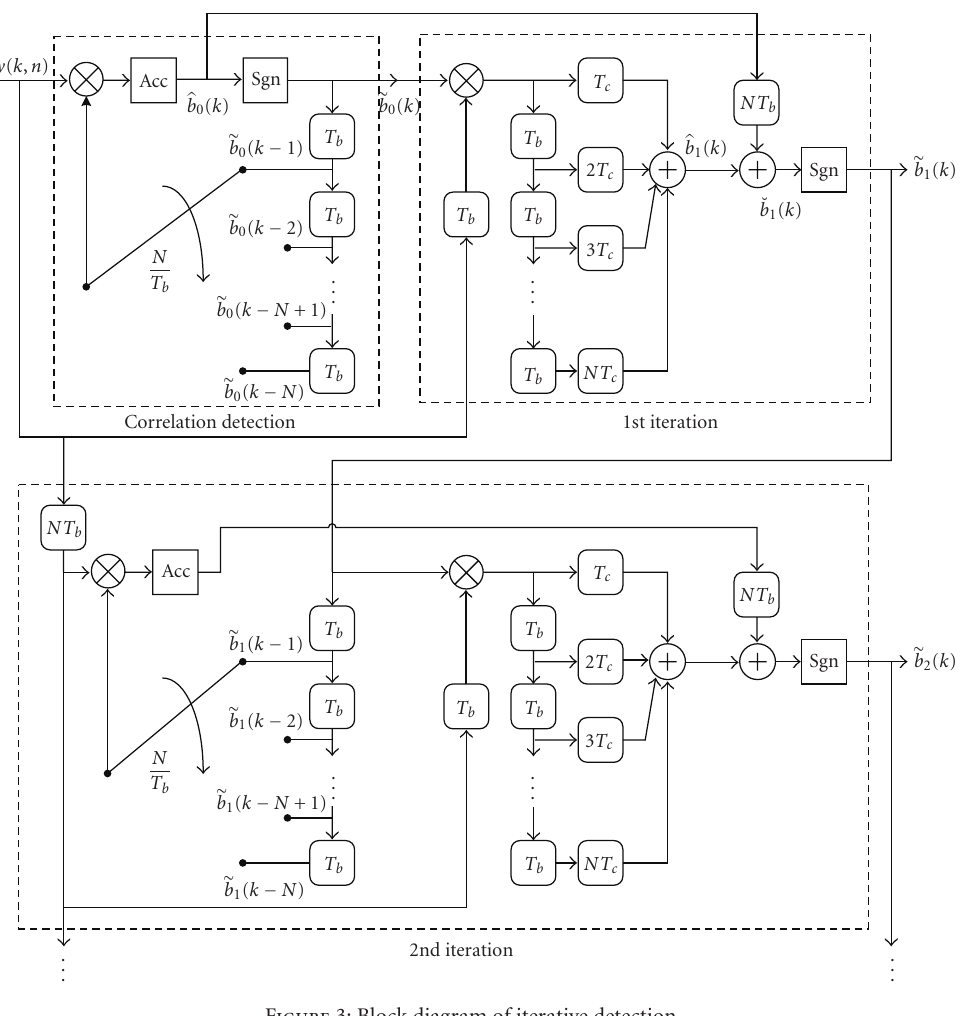
Figure 3: Block diagram of iterative